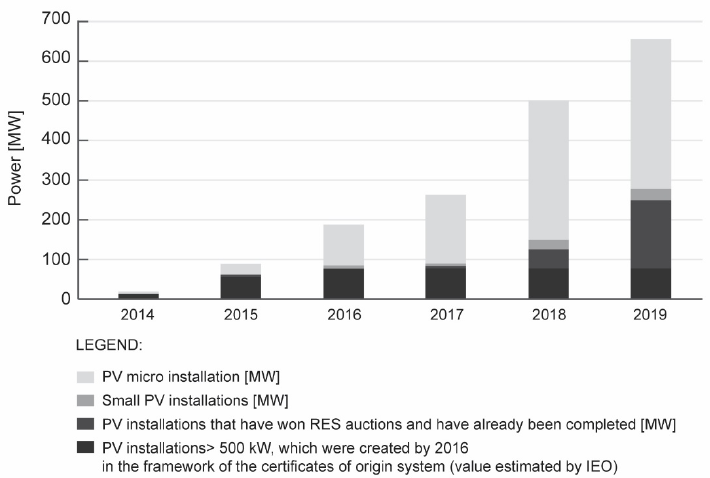
Figure 2. The photovoltaic market in Poland 2019. Source: own study, based on [55].